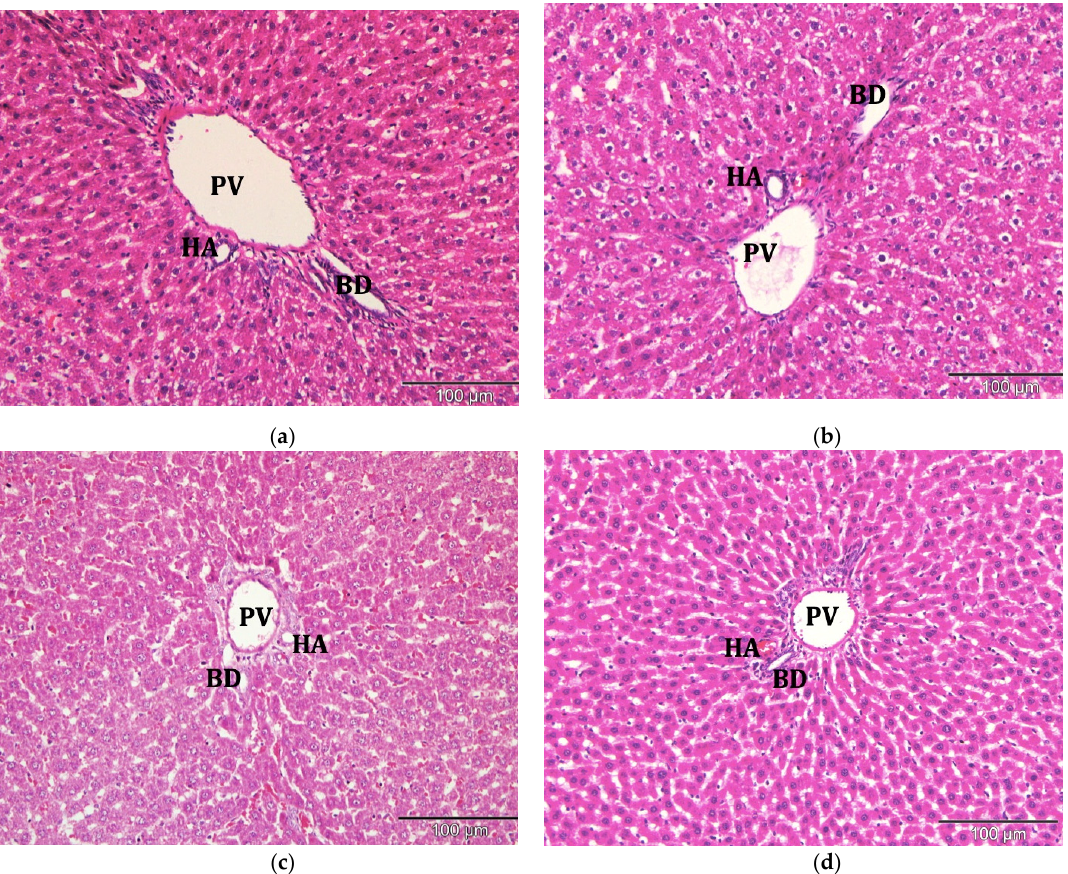
Figure 6. Photomicrograph of liver tissues from ( a ) control; ( b ) commercial acyclovir suspension; ( c ) drug-free SLN and ( d ) acyclovir-loaded SLN treated group (H&E stain, 200×). BD: bile duct, HA: hepatic artery, PV: portal vein.